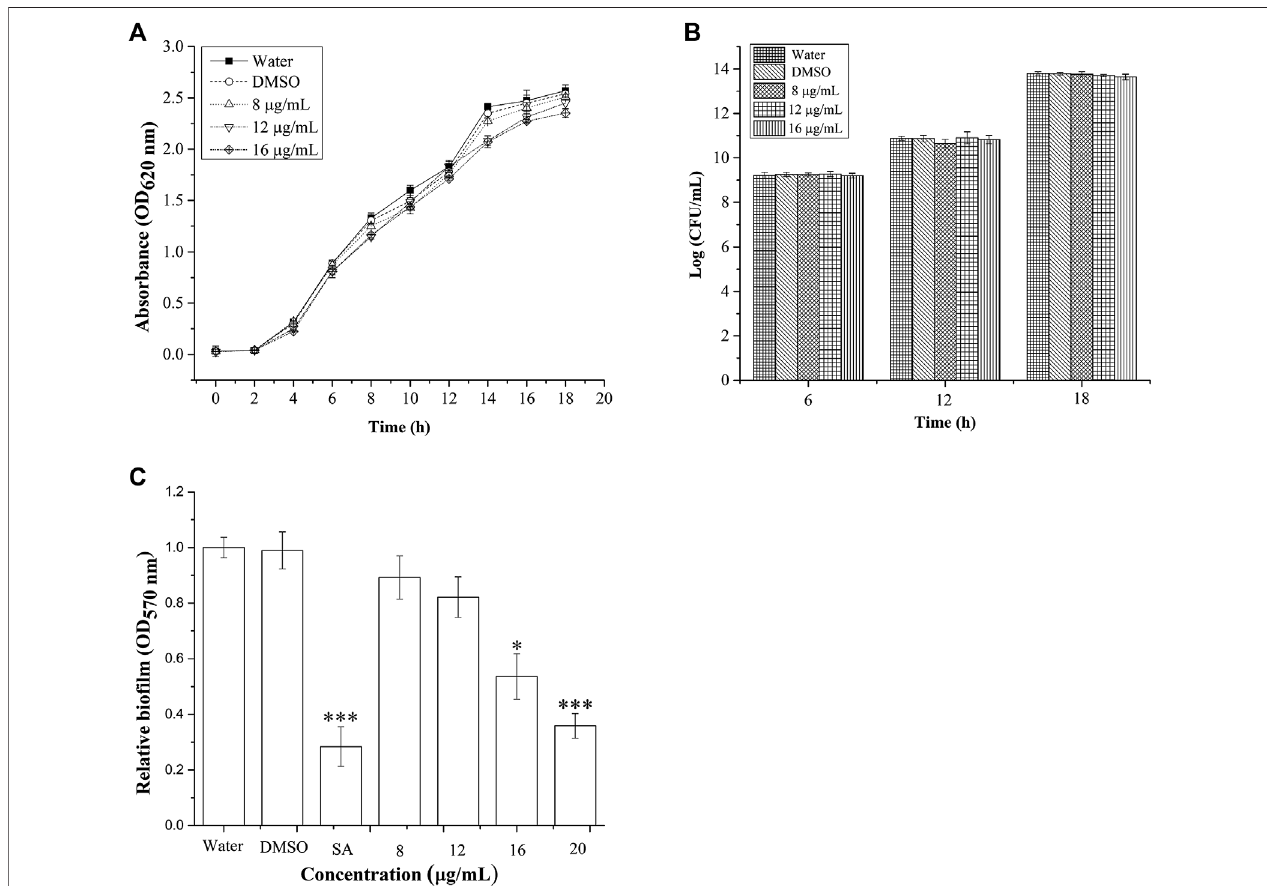
FIGURE 2| Effect of BG138 on P. aeruginosa growth and bio fi lm. (A) Growth was determined for 18 h at different concentrations of BG138 (8, 12, and 16 μ g/ml). Water and DMSO served as the negative control. Error bars represent the standard error of three measurements, (B) surviving planktonic cells expressed as Log CFU/ mLinthecultureuntreated(water)andtreatedwithDMSO,BG138(8,12,and16 μ g/ml),and (C) effectofdifferentconcentrationsofBG138(8,12,16,and20 μ g/ml)on bio fi lm formation. SA was used as the positive control. Statistical differences were determined by ANOVA followed by Tukey test. p < 0.05 (*) p < 0.01 (***) versus DMSO